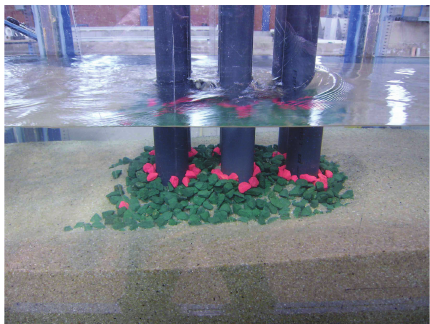
Figure 1: Edge failure mechanism in pile group model. Water flowing leftwards.